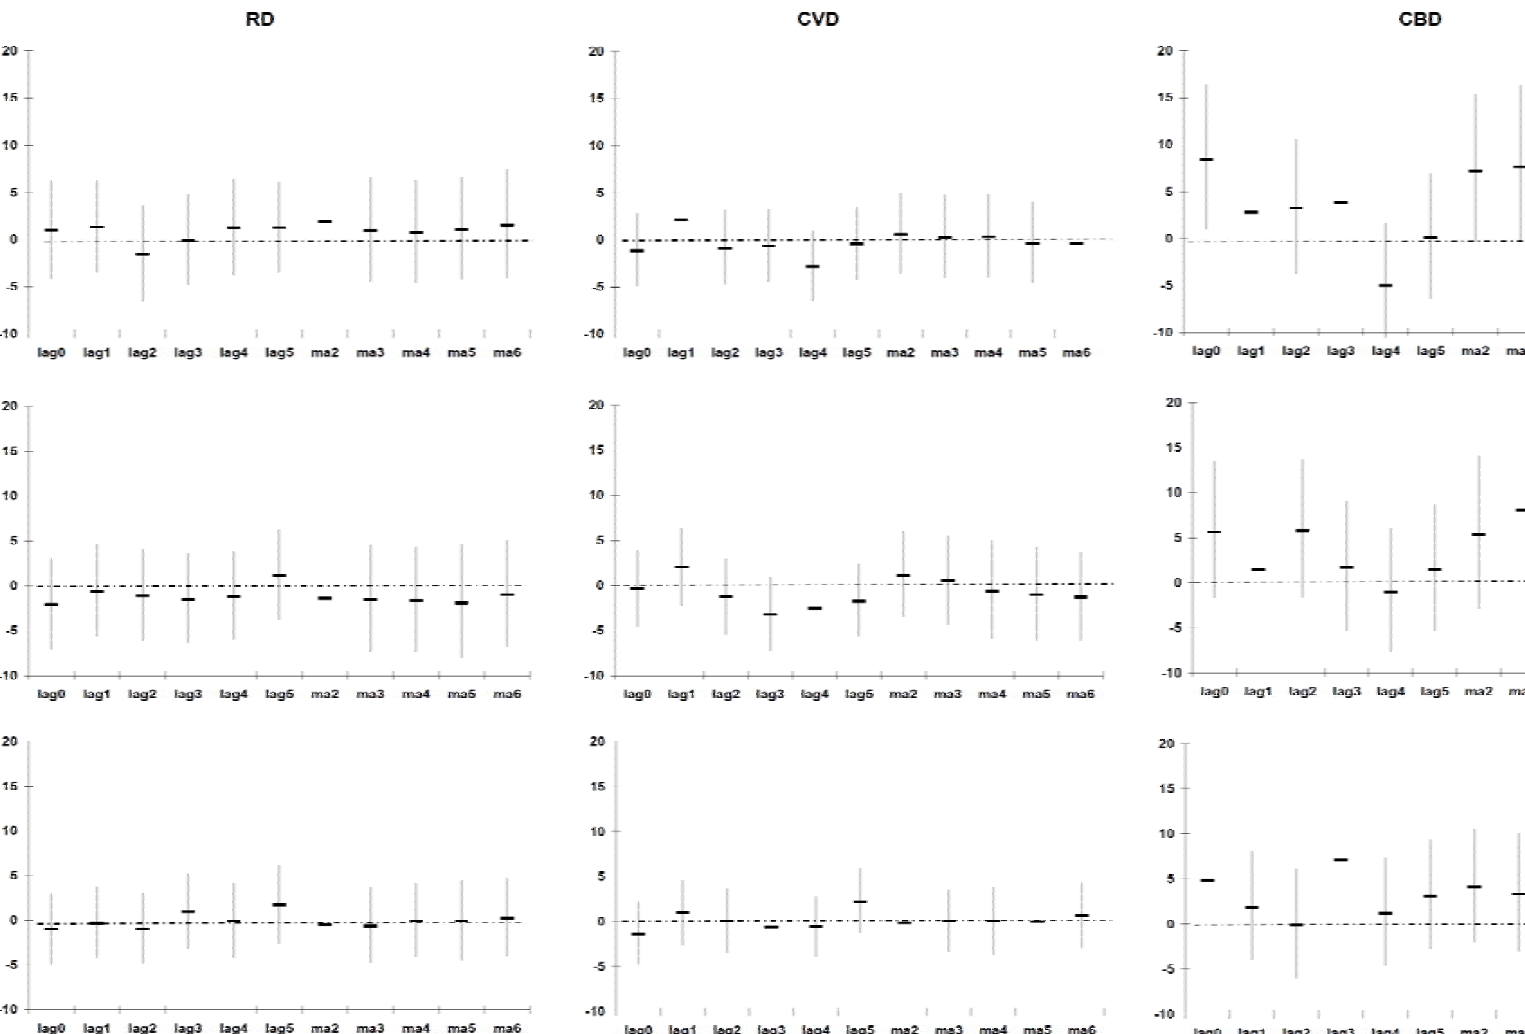
, NO and SO 10 2 2